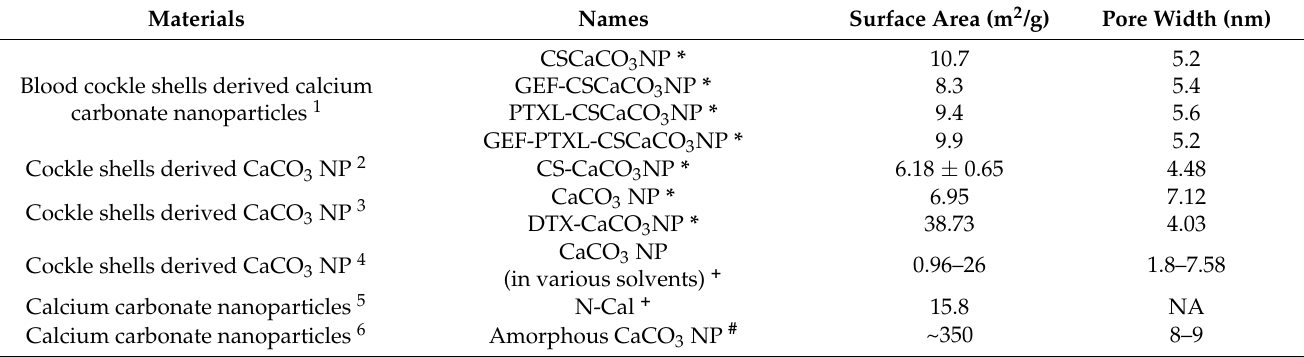
Table 6. Surface area and pore width of various calcium carbonate